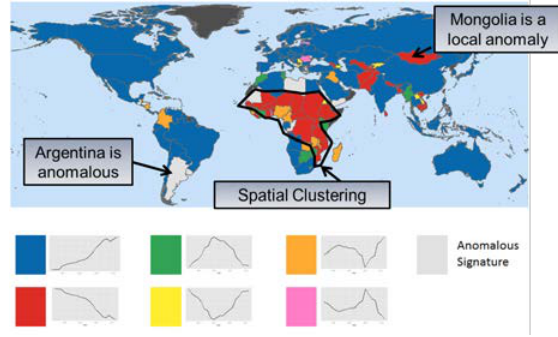
Figure 14. Spatial visualization of explanatory PCA trends